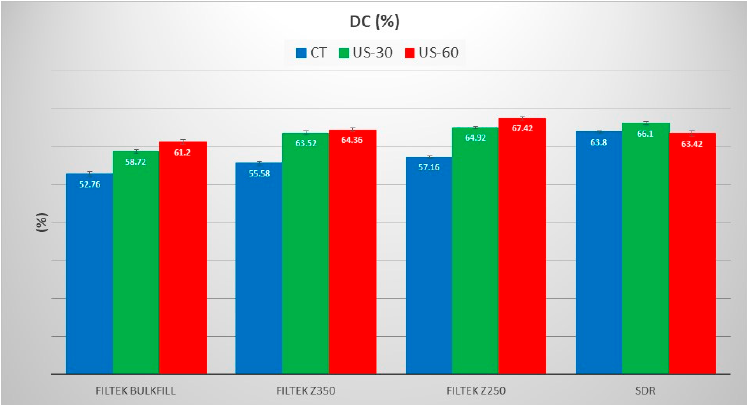
Figure 4. Mean (SD) DC% of composites (Filtek Bulk-fill, Filtek Z350, Filtek Z250, and SDR) without (CT) and with ultrasonic application for 30 s (US-30) and 60 s (US-60). For Bulk-fill and Z350 composites, the complete spectral range and the 900–1200 cm − 1 regions showed slightly less variance where the minimum variance of PC1 was 91% in a complete spectral range of uncured bulk-fill dental composites (data not shown). Bulk-fill and Z350 composites demonstrated (Figure 5) excellent separation between control, 30 s, and 60 s of both cured and uncured dental composites at both the spectral ranges (1590– 1650 cm − 1 and 1700–1750 cm − 1 ) with 100% variance observed in the first component.